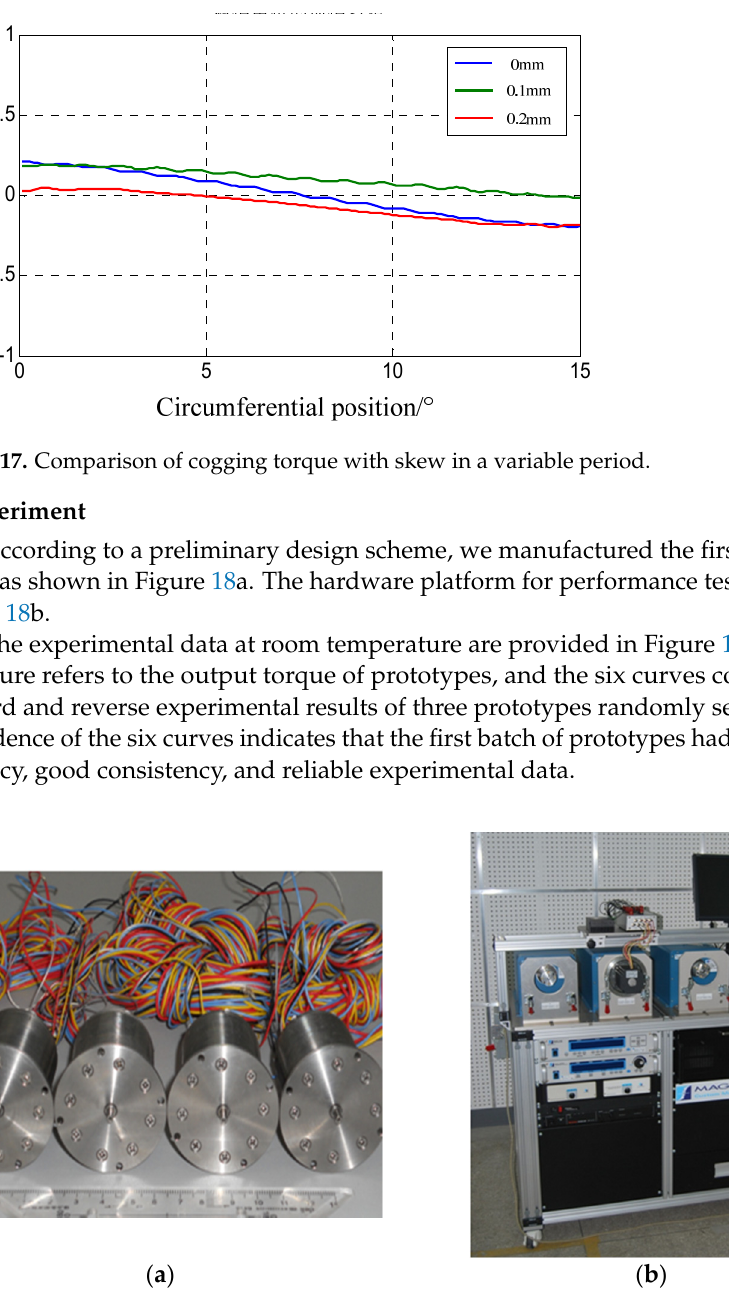
Figure 16. Comparison of cogging torque without skew in a variable period.